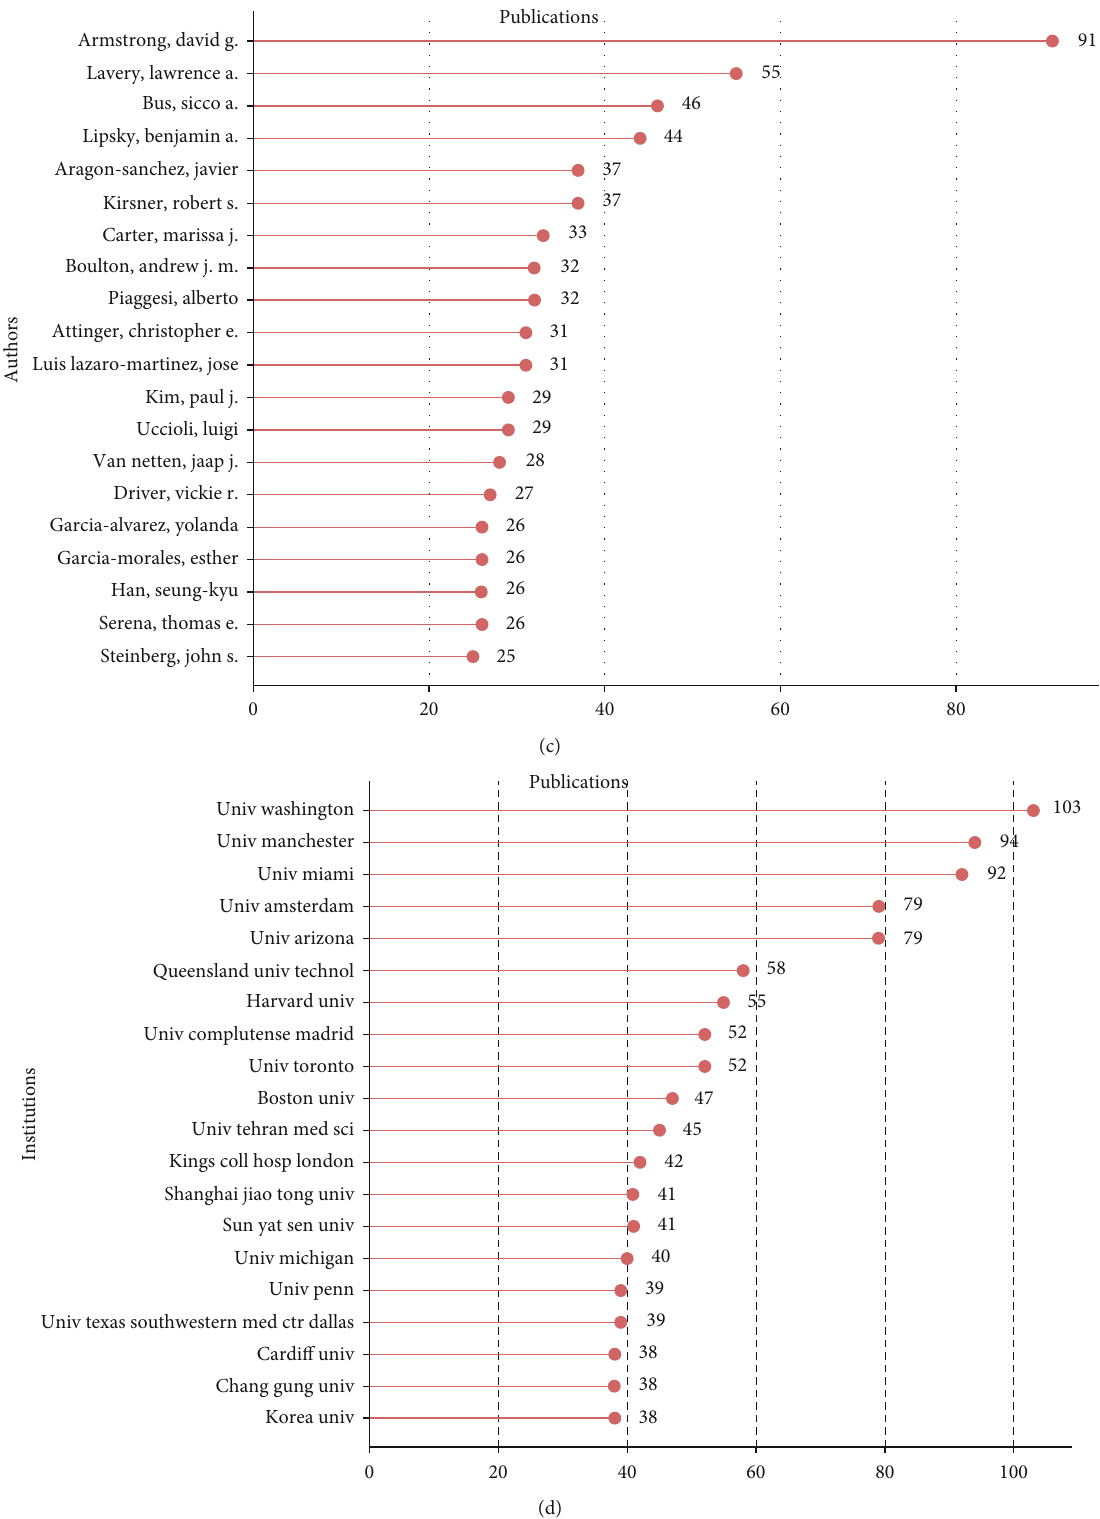
Figure 4: (a) Top 20 journals of publications related to DFU research. (b) The top 20 research productive categories and the number of publications in each category. (c) The top 20 authors of publications. (d) The top 20 institutions with the highest impact and the number of publications for each